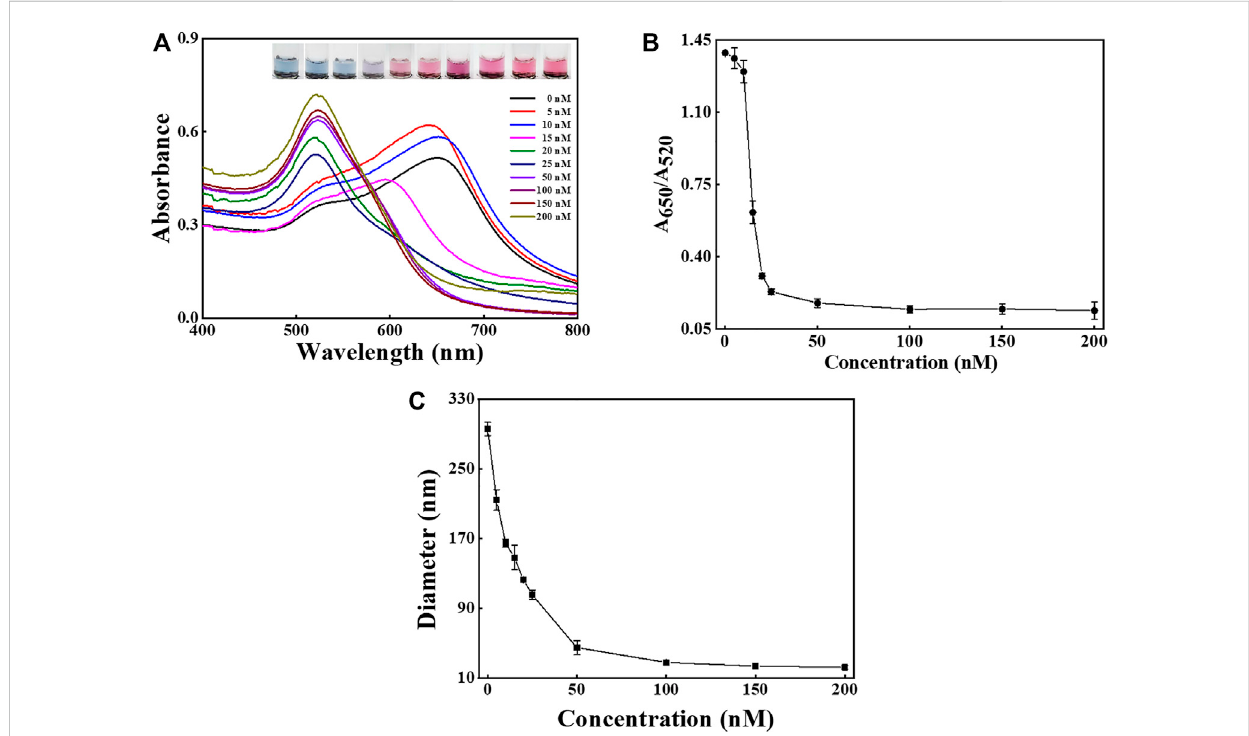
FIGURE 4 Condition investigation.The effect ofaptamer amounts (from 0to 200 nM) onthesensing performance. (A) The UV-Vis spectra and sample images of AuNPs after the addition of aptamer with different concentrations. (B) The values of A 650 /A 520 after the addition of aptamer with different concentrations. (C) TheDLSsizesofAuNPsaftertheadditionofaptamerwithdifferentconcentrations.Theerrorbarsrepresentthestandarddeviationof three independent